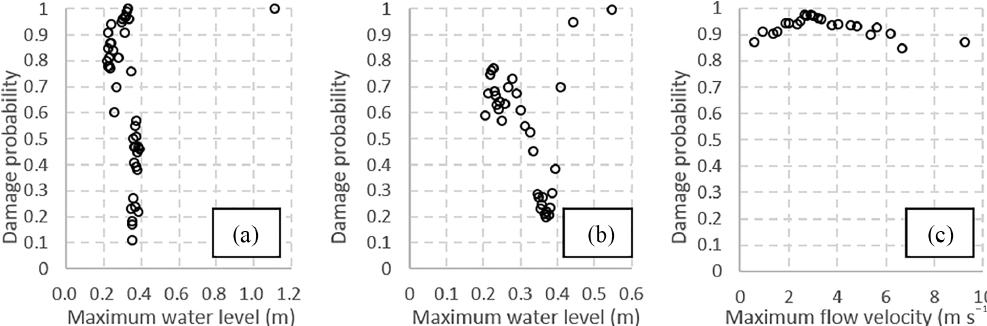
Figure 12. Maximum water level and complete-damage probability for the (a) aquaculture rafts and (b) eelgrass in Mangokuura Lake and for (c) eelgrass in Matsushima Bay.